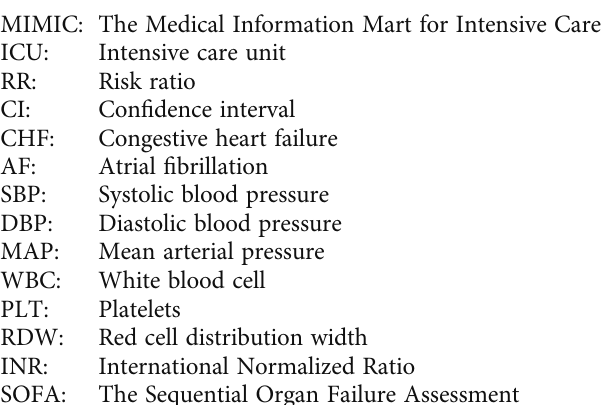
Multivariable logistic regression analysis adjusting respiratory failure, malignant cancer, anticoagulation, liver disease, temperature, WBC, RDW percent, glucose, and bicarbonate; BUN: blood urea nitrogen; Cr: